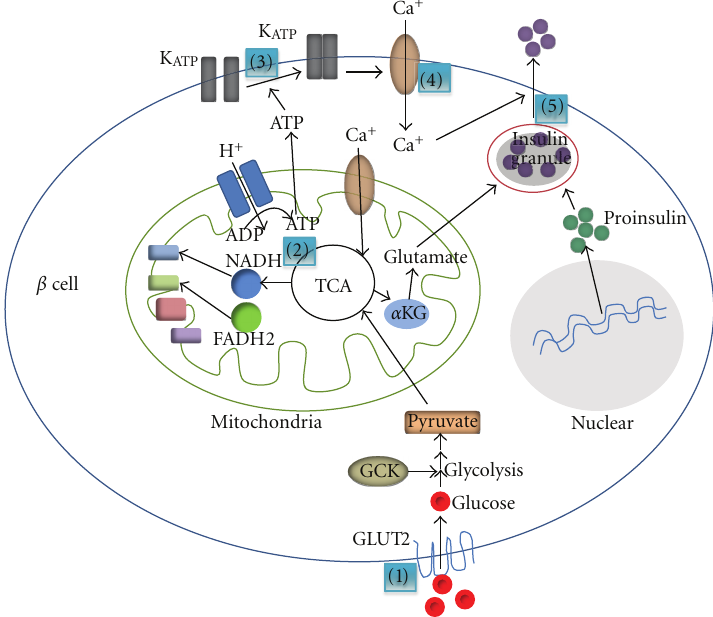
Figure 1: The processes of GSIS . (1) Glucose is transported into the β cells through the translocation of the glucose transporters, especially GLUT2; (2) generation of ATP through the oxidation of glucose; (3) elevation the ratio of ATP/ADP induces closure of cell-surface ATP- sensitive K + (K ATP ) channels, leading to cell membrane depolarization; (4) extracellular Ca 2+ influx into the β cell; (5) a rise in cytosolic Ca 2+ triggers the exocytosis of insulin granules. K ATP : ATP-sensitive K + channels, GLUT2: glucose transporter 2, GCK: phosphorylation by glucokinase, GPDH: glycerophosphate dehydrogenase, TCA cycle: tricarboxylic acid cycle, NADH: reduced form of Nicotinamide adenine dinucleotide, FADH2: reduced forms of flavin adenine dinucleotide, α KG: alpha-ketoglutarate, ADP: adenosine diphosphate, ATP: Adenosine-5 (cid:3)